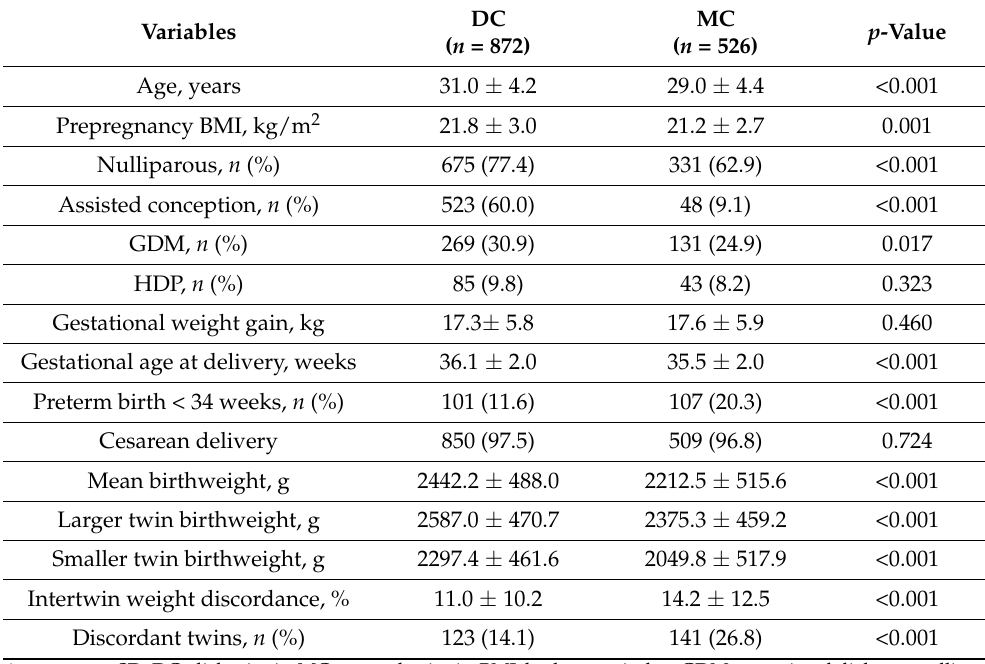
Table 1. Characteristics of study participants.